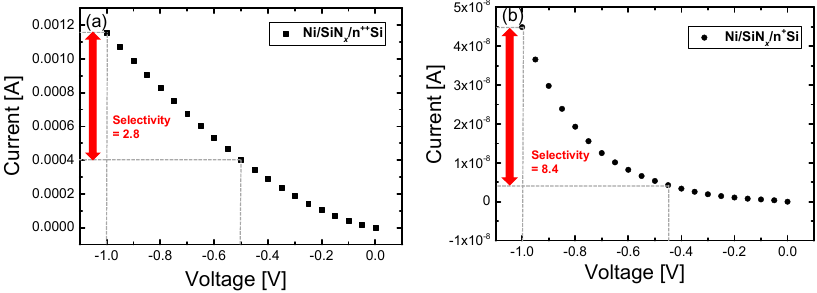
Figure 7. Selectivity in the LRS for ( a ) the Ni/SiN x /n ++ Si device and ( b ) the Ni/SiN x /n + Si device.